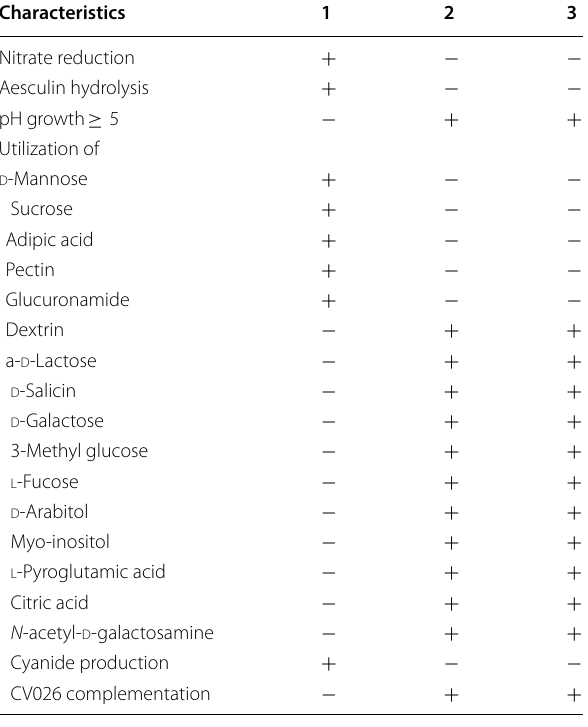
Table 2 Phenotypic characteristics of (1) C. violaceum ATCC 12472 T , (2) Chromobacterium strain ATCC 31532, and (3) C. subtsugae PRAA4-1 T C +